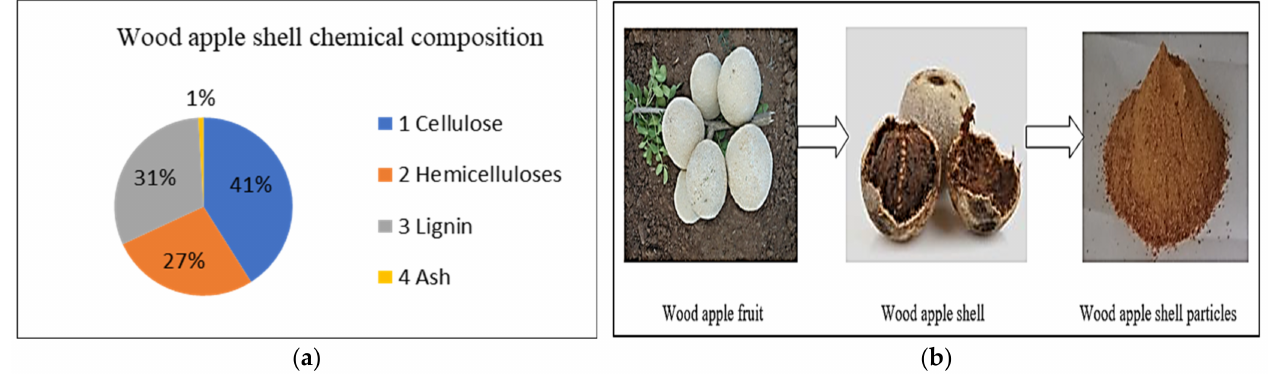
Figure 14. ( a ) Wood apple shell chemical composition and ( b ) formation of wood apple shell biomass.